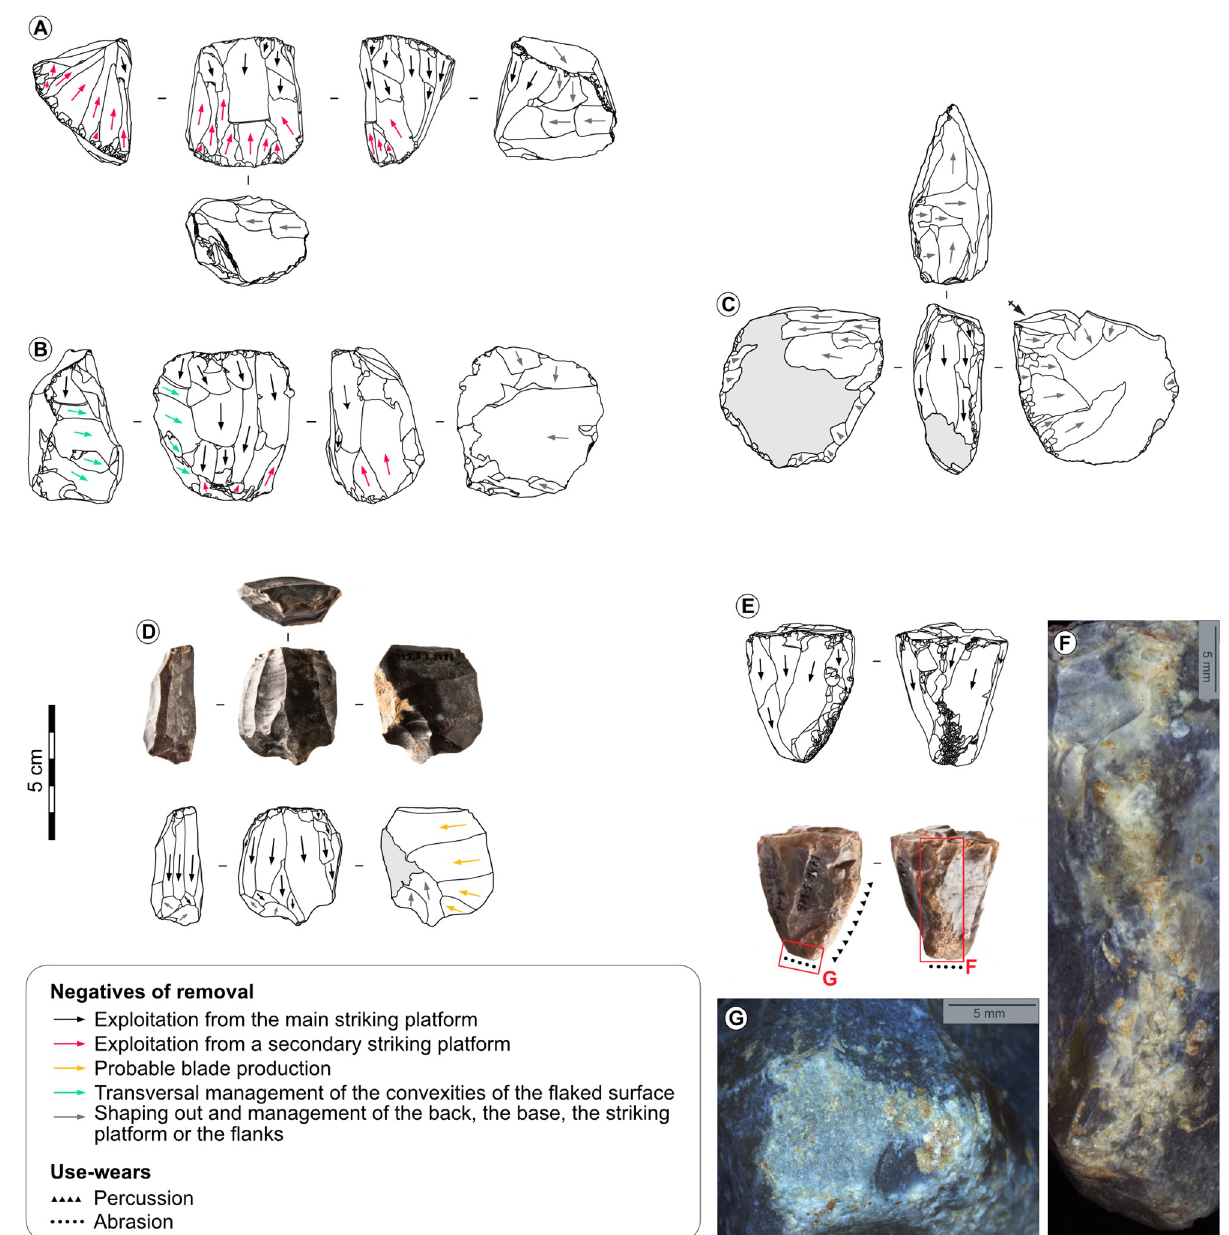
Fig 8. Bladelet cores from La Marche. A, B, D-Prismatic cores on block. C-Core on cortical flake. E-Pyramidal core on block recycled to strike and abrade hard materials. F-Percussion wears on core n˚E. G-Abrasion wears on core n˚E, credits: Gauvrit Roux, 2019.